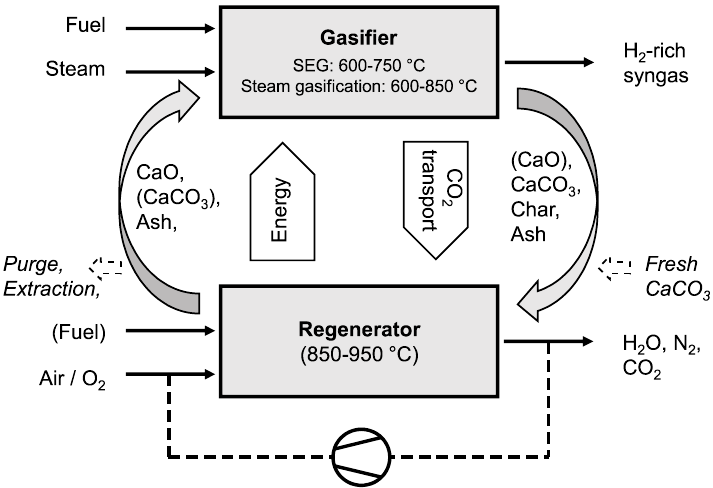
Figure 3. Schematic diagram of sorption enhanced gasification (SEG) process (up to 750 °C) and extended steam gasification mode (up to 850 °C); option of oxy-fuel operation.